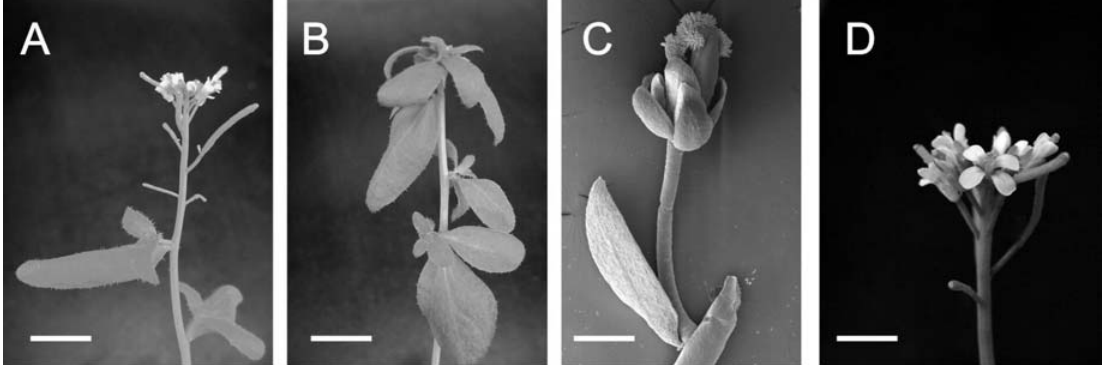
Figure6 -The PcLFY expressiondrivenbythe LFY promotercancomplementan Arabidopsis strong lfy mutation.A:wild-typeinflorescence(Columbia ecotype)showingflowerbudsatdifferentdevelopmentalstages.B:maininflorescenceaxisofan lfy-26 mutant.Solitaryflowersarereplacedbyacauline leaf (bract) adjacent to a lateral inflorescence axis or an abnormal flower. C: SEM image of an abnormal flower of the lfy-26 mutant. Note the cauline leaf and the homeotic conversion of petals and stamens in sepal-like organs and carpel-like organs, respectively. D: A homozygous transgenic (LFY:: PcLFY ) lfy-26 mutant showing a wild-type phenotype, indicating the complementation of the lfy mutation by the expression of PcLFY . Bars: A and B: 6 mm; C: 400 µ m; D: 3 mm.